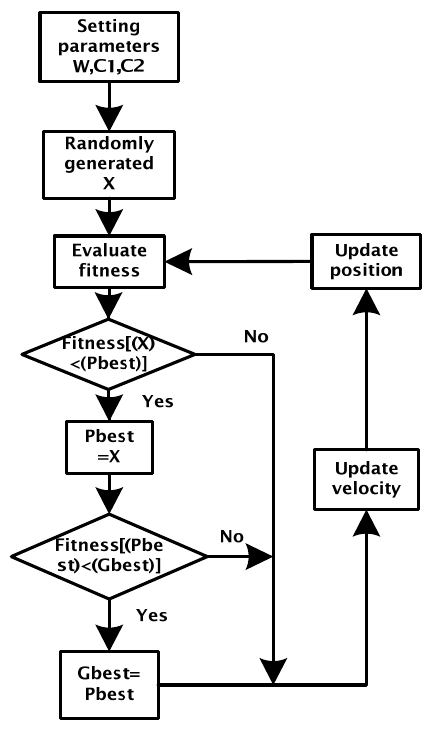
Figure 2. PSO algorithm process block